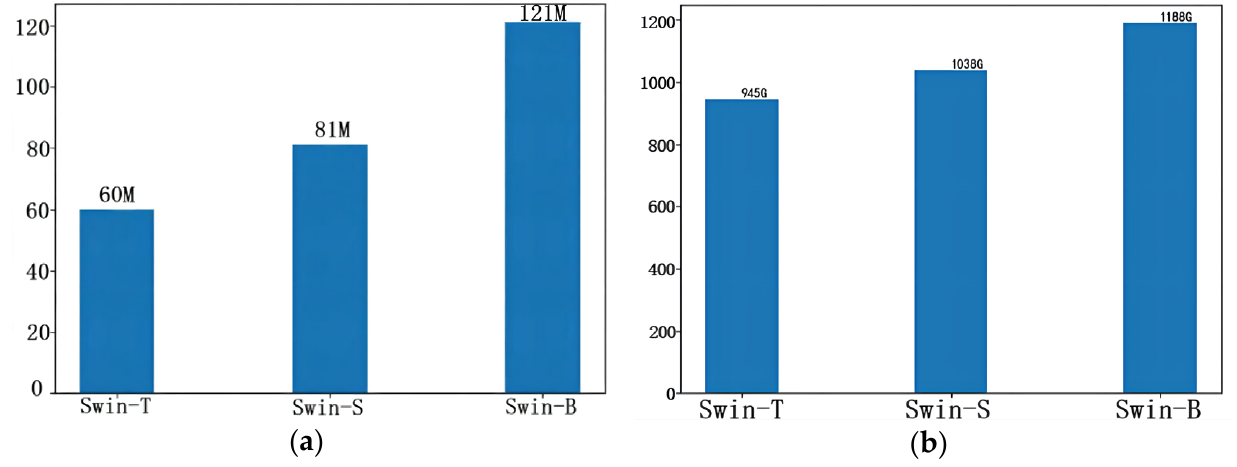
Figure 12. Comparison of params and flops in segmentation mission. ( a ) Comparison of params; ( b ) Comparison of flops.